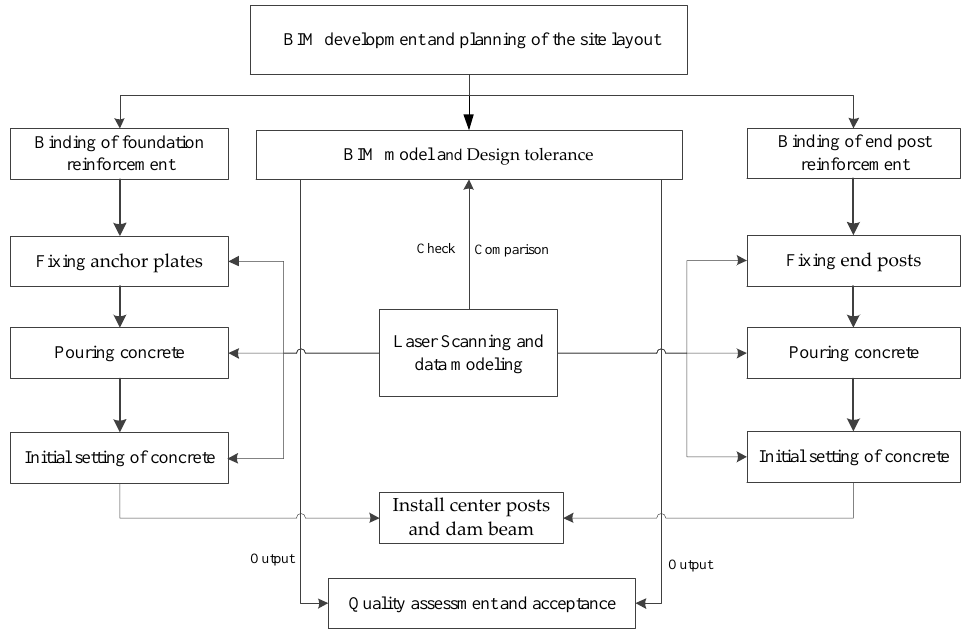
Figure 4. The workflow of quality control for a removable floodwall system.